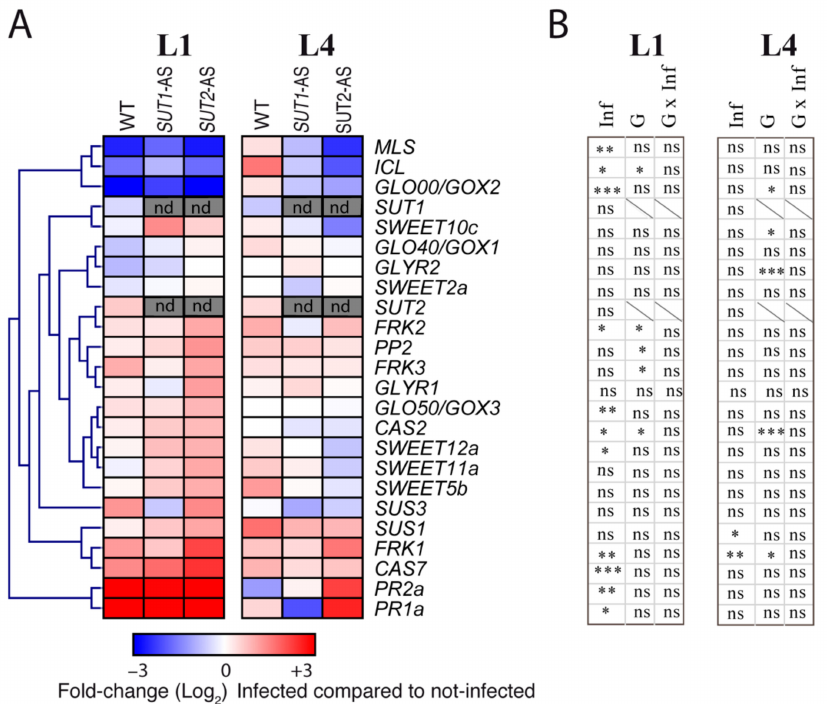
Figure 9. Transcript profiling of candidate genes in infected plants. ( A ) Inserted heat maps showing fold changes between infected and noninfected plants in each genotype in L1 and L4 leaves ( n = 4). Fold changes were determined after normalization by the reference genes, and values are shown on a log 2 scale, with blue values for metabolites showing a smaller content due to infection and red values for a higher content. In grey, not determined (nd). ( B ) Results of the two-way ANOVA for each gene, with the effects of infection (Inf), genotype (G) and interaction (G × Inf). p -values: * p < 0.05, ** p < 0.01 and *** p < 0.001. ns, not